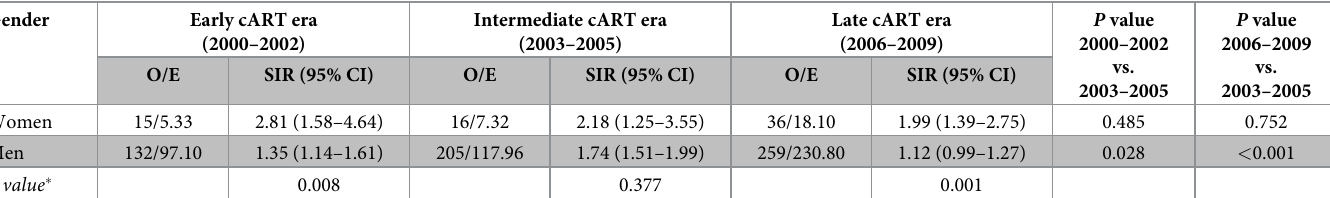
Table 2. Standardized incidence ratios by gender in each calendar period.